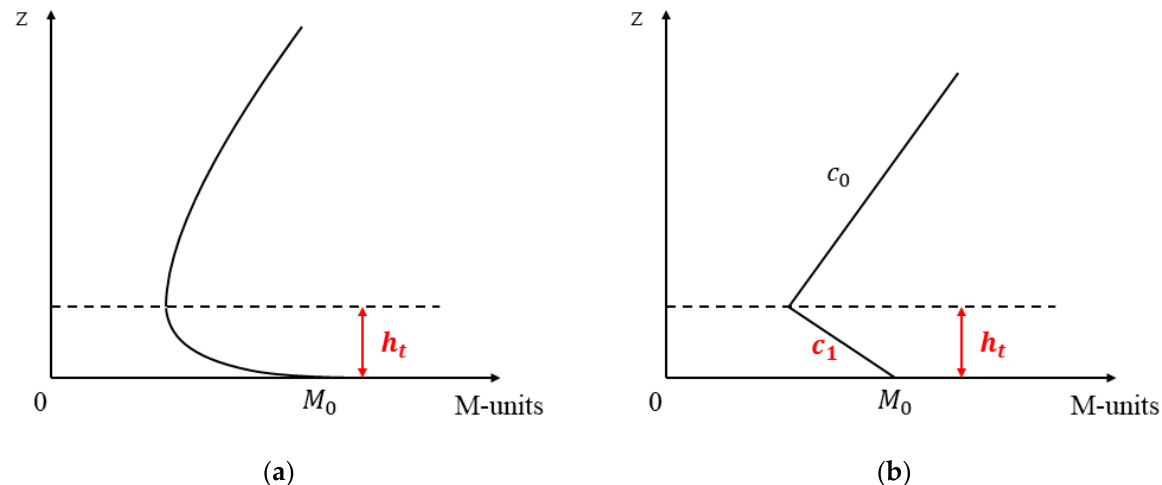
Figure 2. Evaporation duct. ( a ) One-parameter; ( b ) Two-parameter.